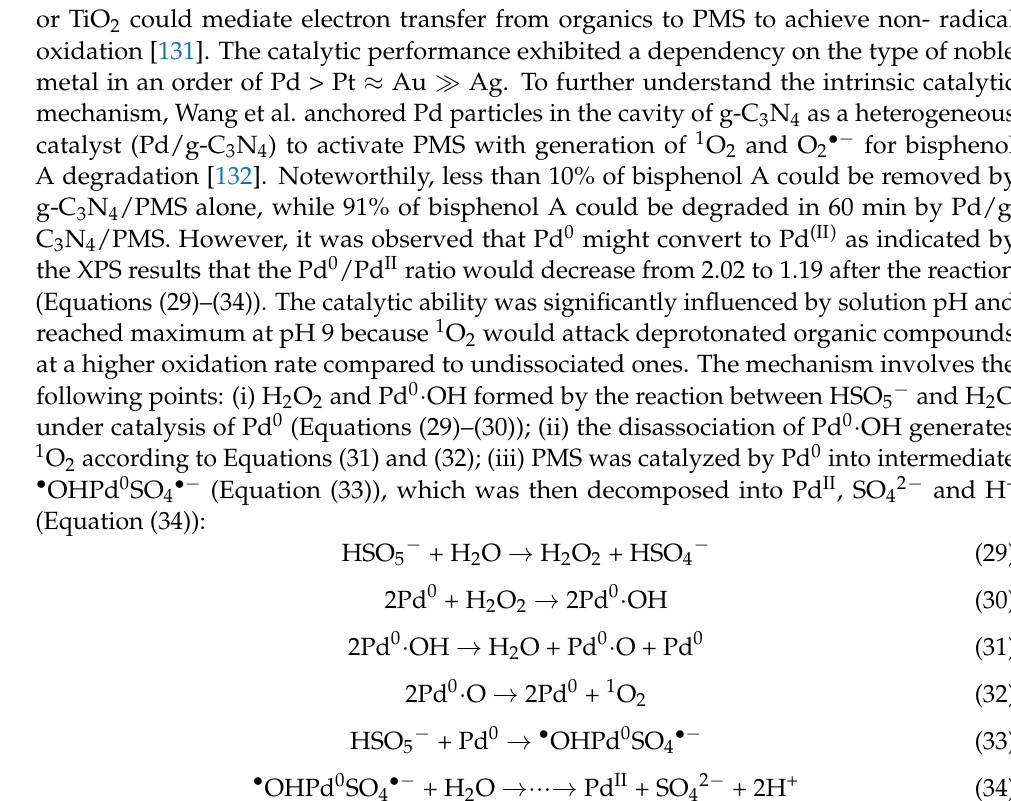
Table 4. Performance and mechanism of metal-carbon nanocomposite catalysts for PDS/PMS oxidation of pollutants.